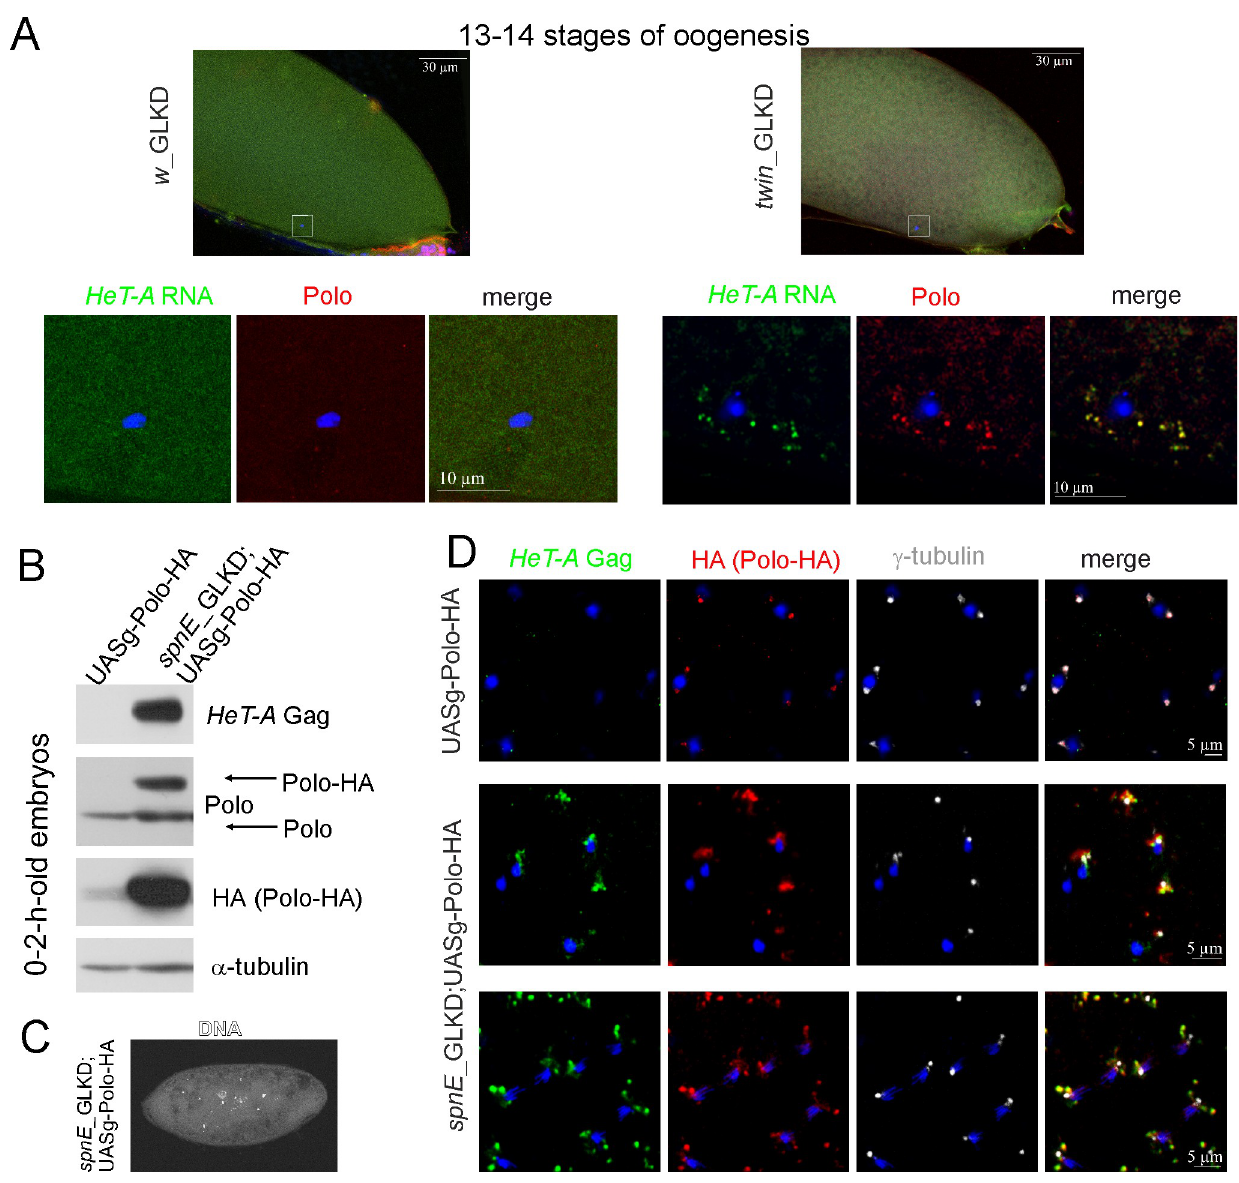
Fig 6. Retention of maternal Polo is mediated by its interaction with abundant telomeric HeT-A ribonucleoprotein particles. (A) HeT-A RNA FISH (green) combined with Polo (phosphorylated form, red) immunostaining in the control ( w _GLKD) and twin _GLKD egg chambers at 13–14 stages. The upper images demonstrate the general view; the lower panels show the enlarged area around the oocyte nucleus obtained with a 63 × objective lens. (B) Western blot analysis of 0–2-h-old embryo lysates shows the overexpression and accumulation of Polo-HA in spnE _GLKD embryos. The antibodies are indicated on the right. (C) DAPI staining of spnE _GLKD;UASg-Polo-HA embryos reveals developmental arrest at early syncytial cleavage stage. (D) Co- localization of HeT-A Gag (green) and Polo-HA (red) in the spnE _GLKD;UASg-Polo-HA syncytial embryos. γ -tubulin appears in grey, and DNA appears in